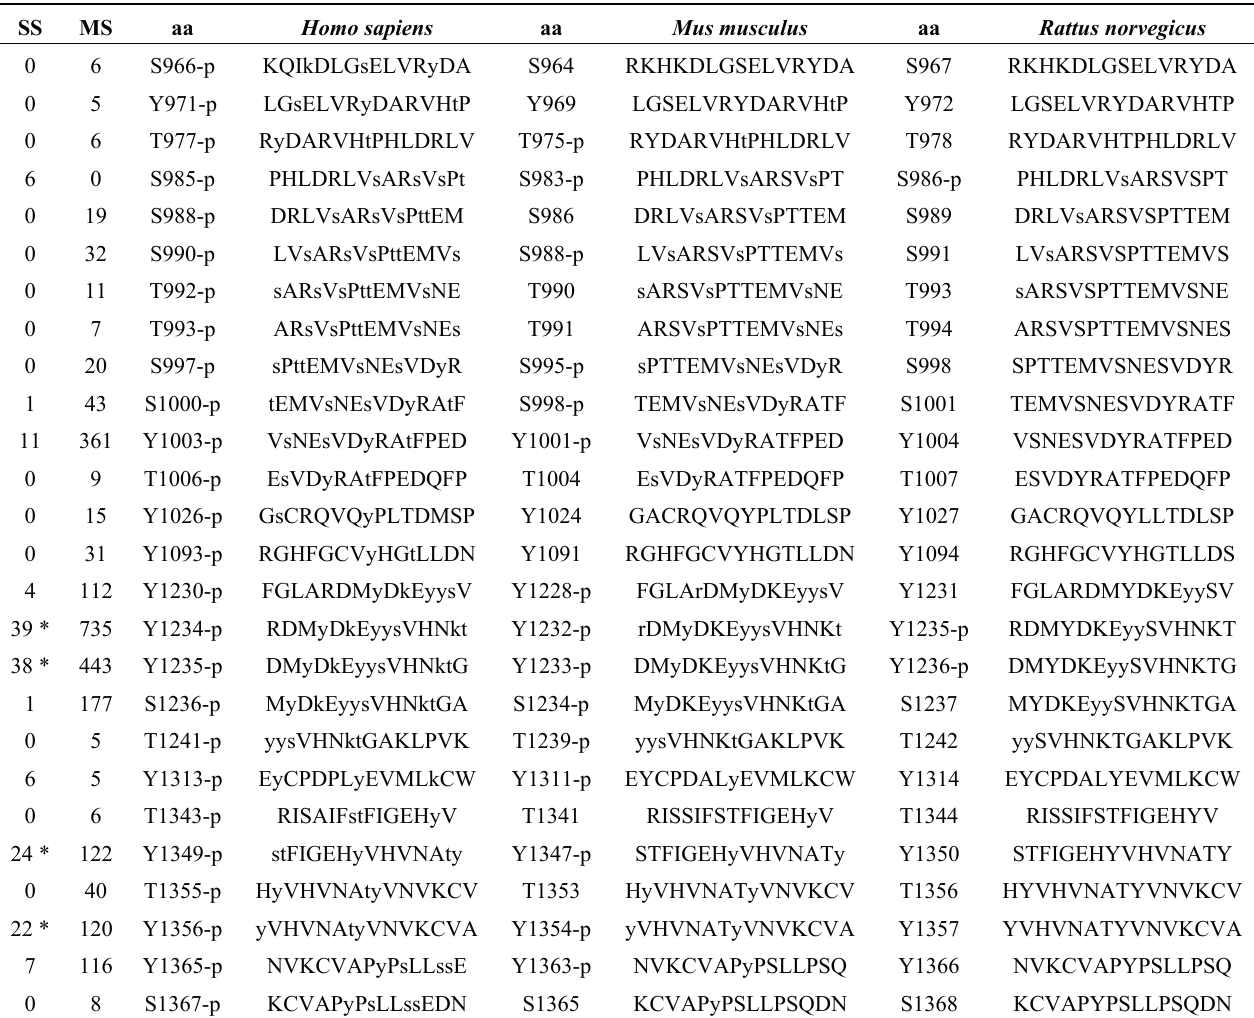
Table 1. MET phosphorylation